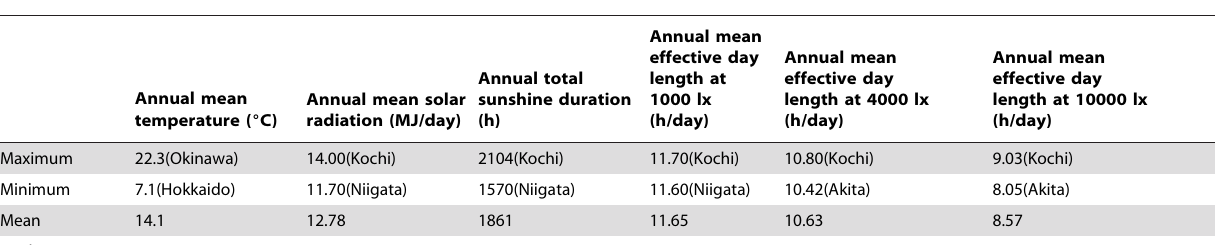
Table 2. Basic statistics for climatic